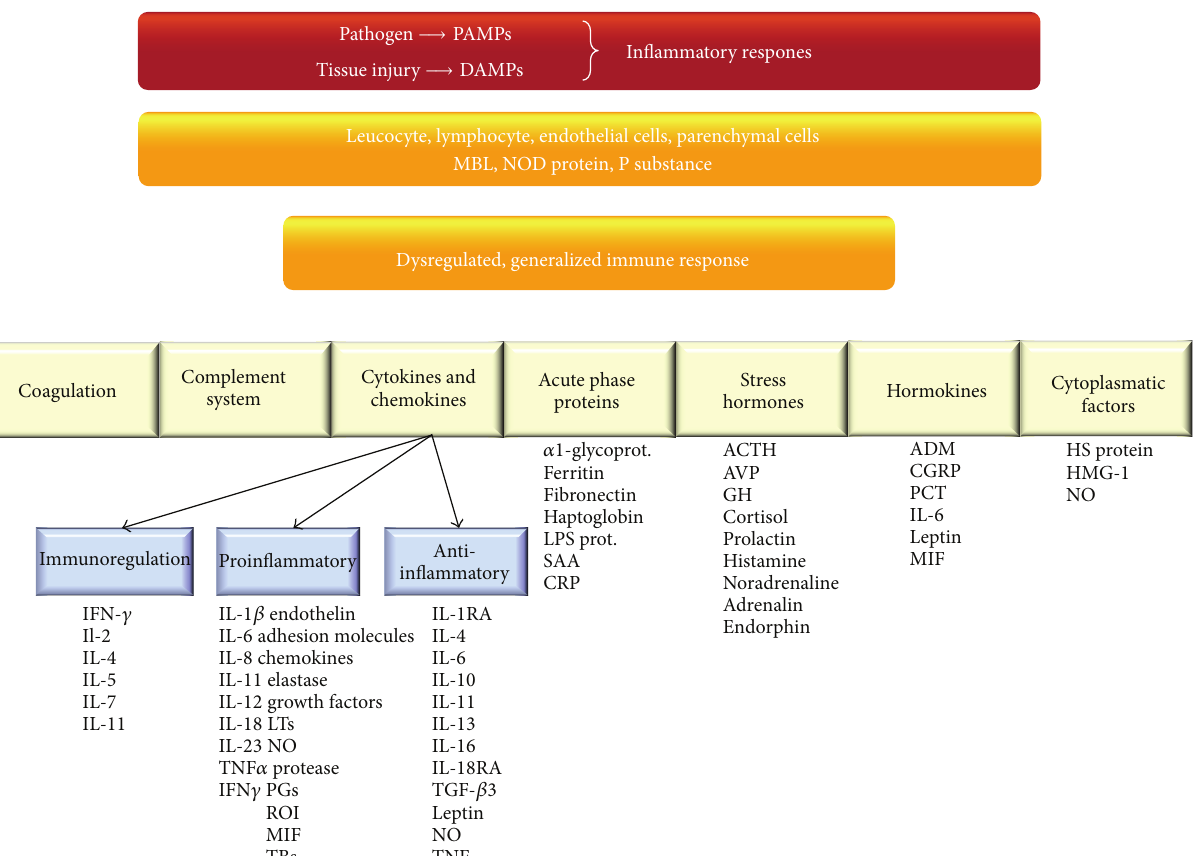
Figure 2: The main pillars of systemic inflammatory response. PAMPs: pathogen-associated molecular pattern, DAMPs: damage-associated molecular pattern molecules, MBL: mannose-binding lectin, NOD protein: nucleotide-binding oligomerization domain protein, and NALP: a type a NOD like receptors. For explanation, see